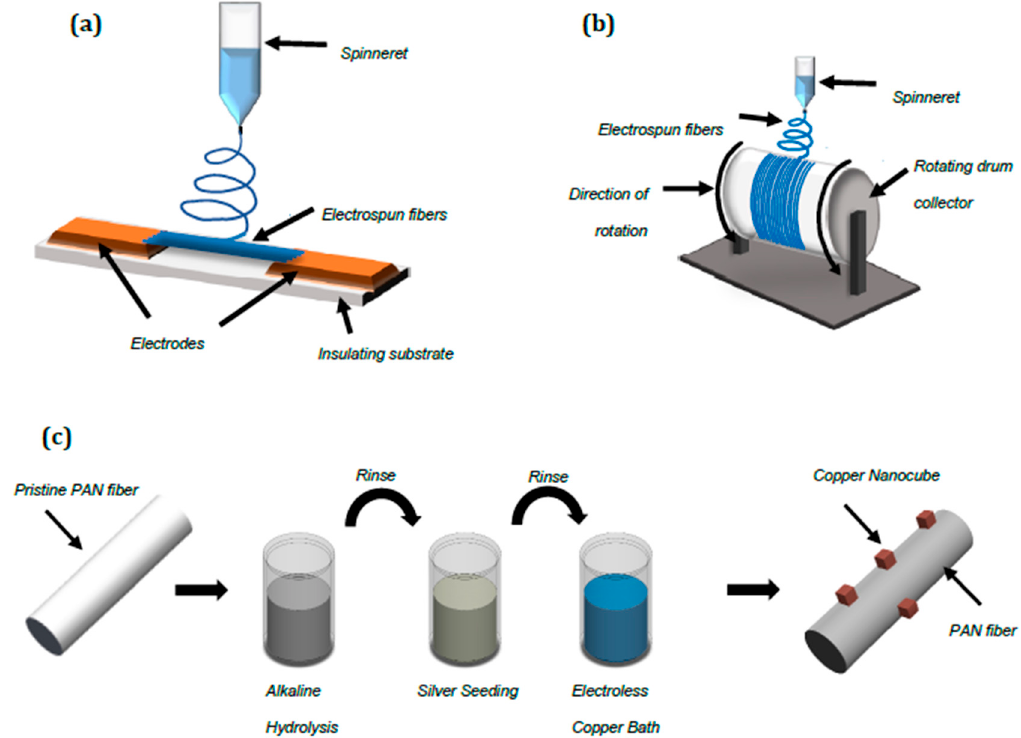
Figure 1. ( a ) Parallel electrode configuration for polyacrylonitrile (PAN) aligned nanofiber processing. ( b ) Rotating drum configuration for PAN aligned microfiber processing. ( c ) Schematic of the electroless deposition procedure for nanocube growth .